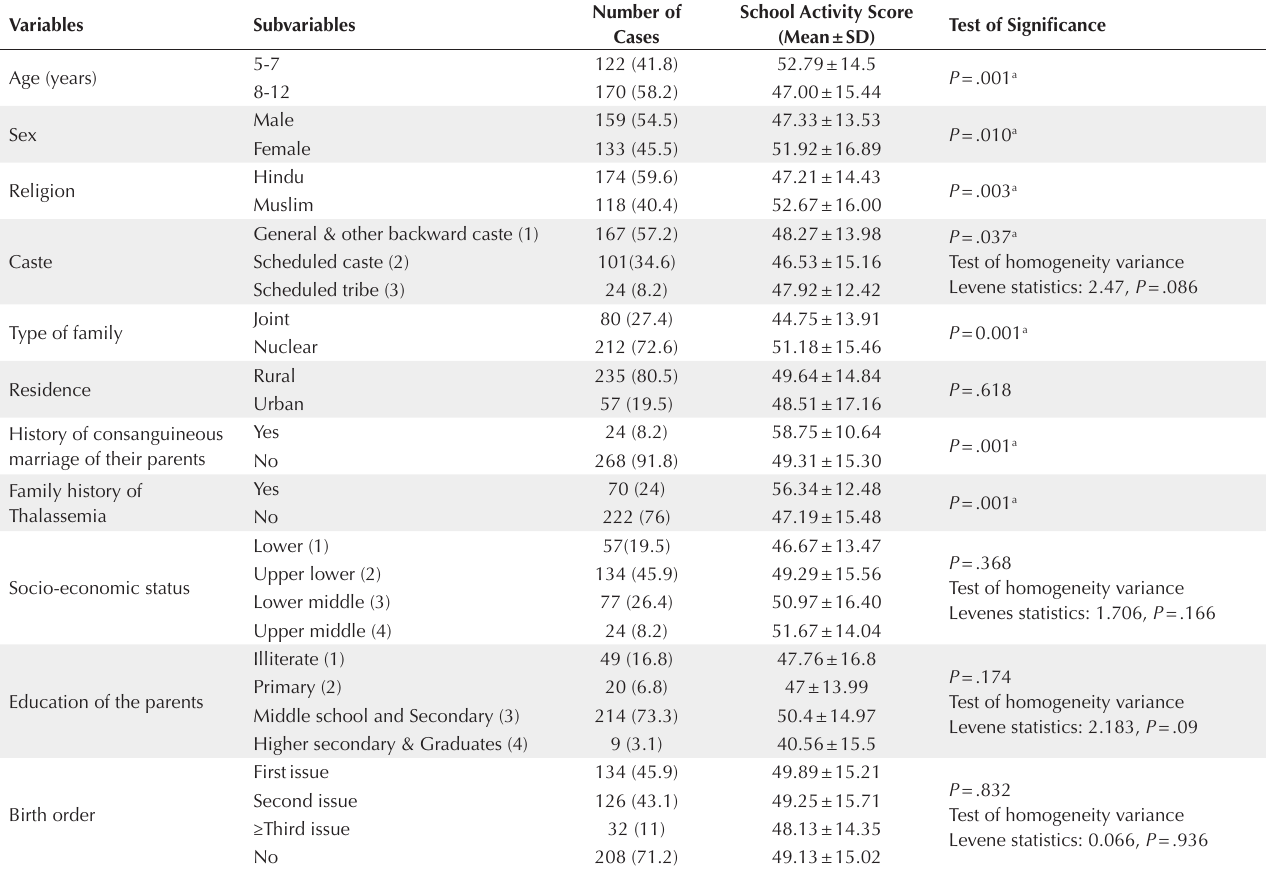
Table 2. Distribution of School Activity Score According to Socio-Demographic Factors (n=292)